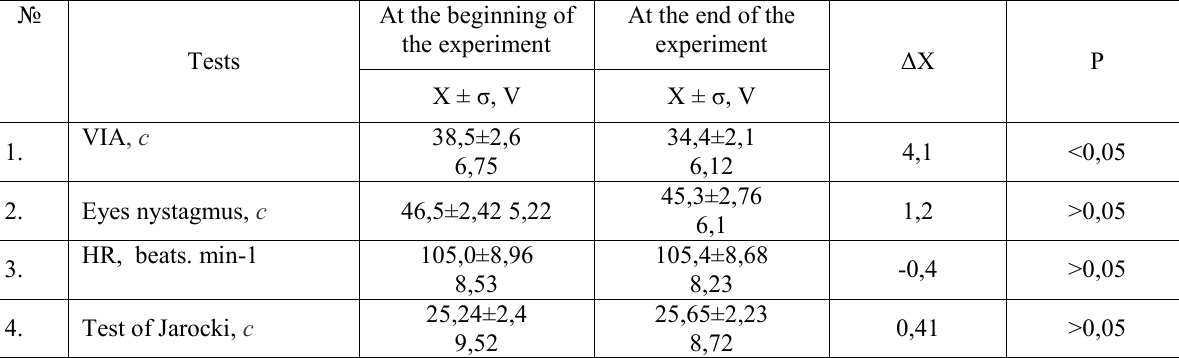
Dynamics of indicators of sustainability of the vestibular analyzer young fighters all-rounders aged 6-8 years involved in military-sports all around the traditional program (control group,